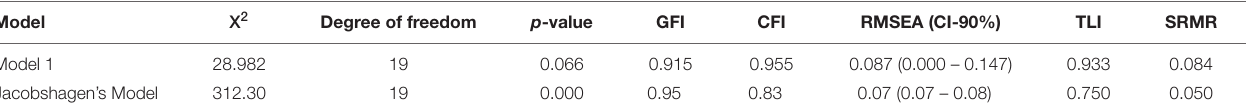
FIGURE 1 | Model 1 for illegitimate tasks’ construct. TABLE 4 | Confirmatory factor